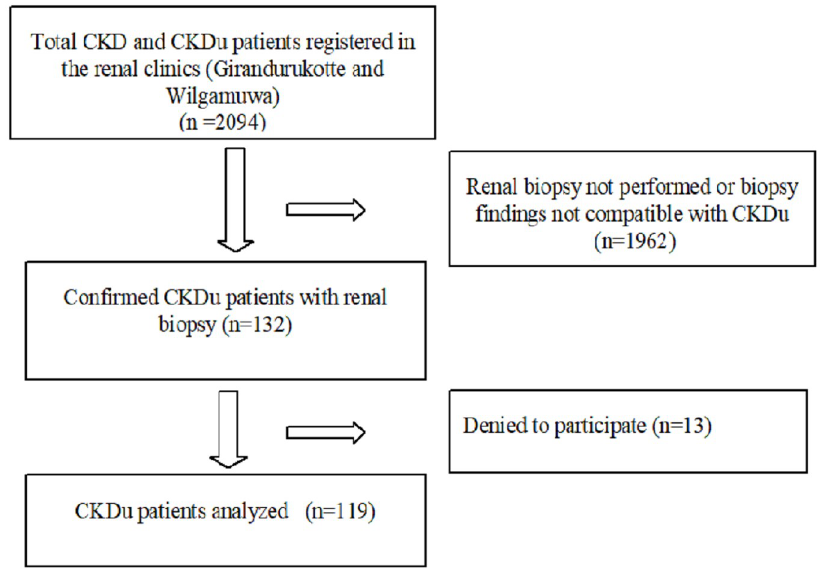
Fig 1. Flow chart of the study